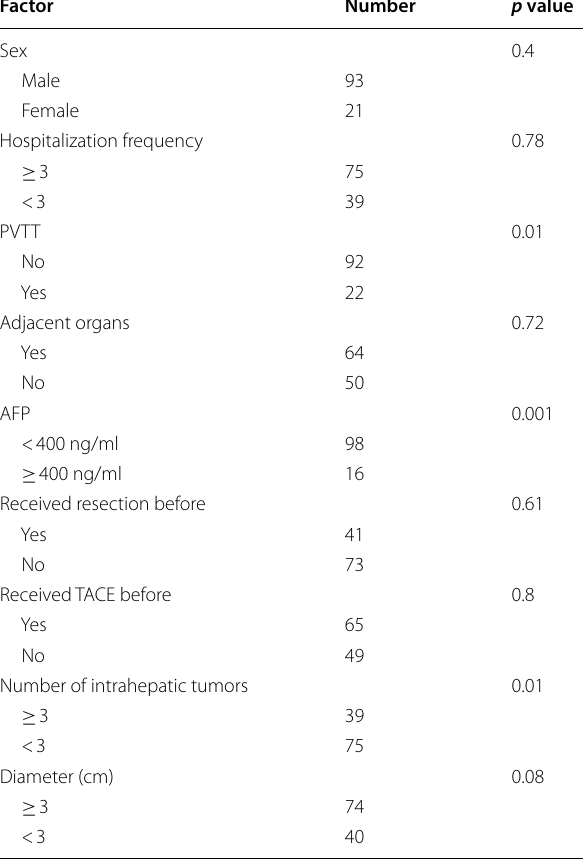
Table 2 Univariate analysis of the risk factors of local progression-free survival